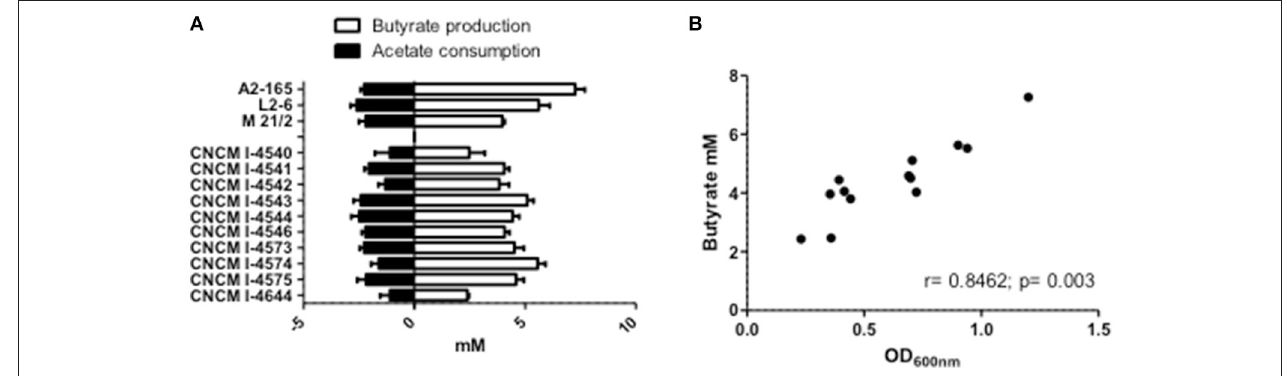
FIGURE 5 | SCFA metabolism of F. prausnitzii strains in vitro . (A) Acetate and butyrate concentrations after 20h growth of strain in YBHI supplemented medium. The concentration of control media was subtracted for each measurement have been done at least in triplicate. (B) Correlation between OD 600nm and butyrate production.